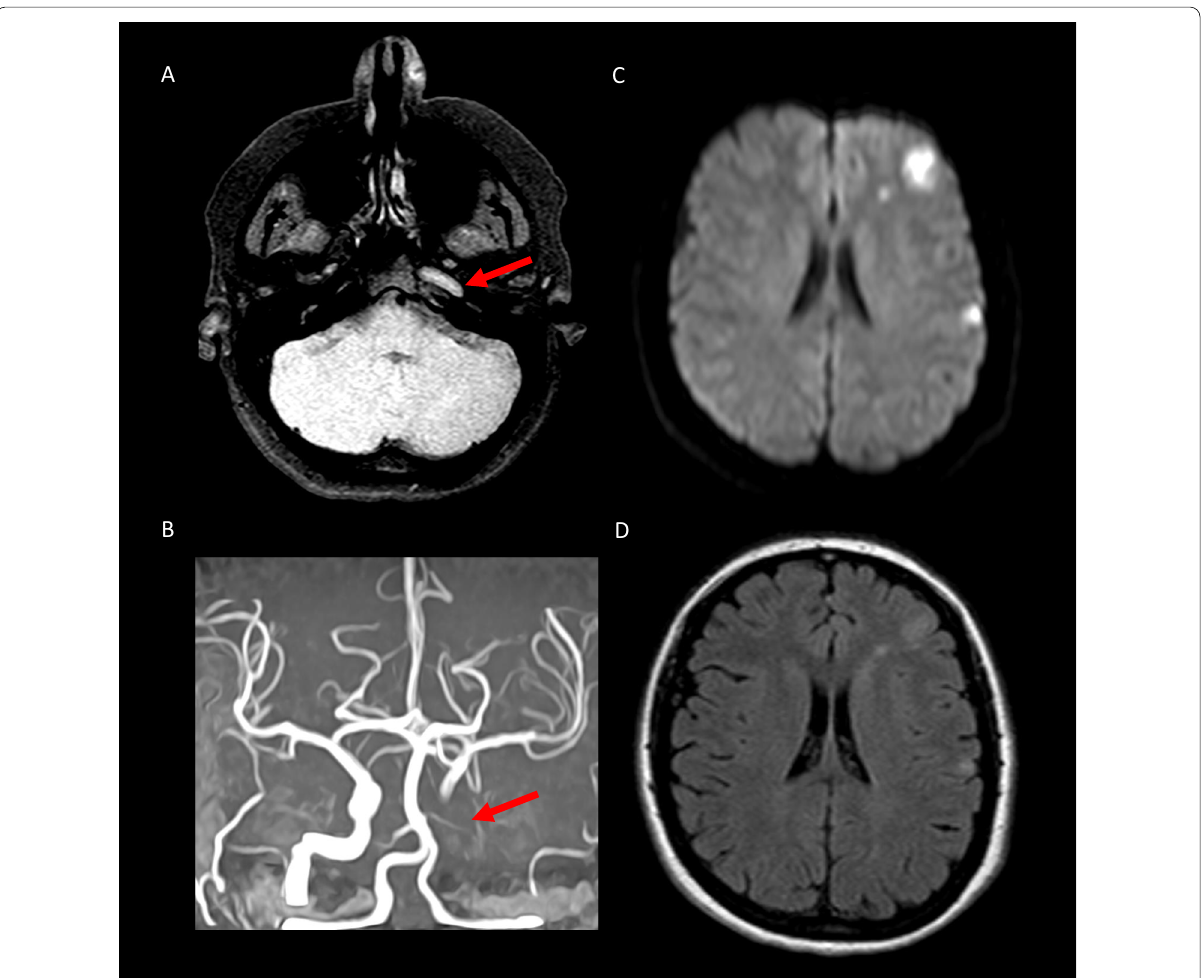
Fig. 1 a Axial T1 fat saturated and b coronal Time Of Flight (TOF) MRI images at 1.5 T show evidence of left intracranial ICA thrombotic occlusion in petrous to clinoid ICA segments. c Axial diffusion weighted (DW) and d Fluid Attenuated Inversion Recovery (FLAIR) images reveal concomitant downstream infarction in MCA